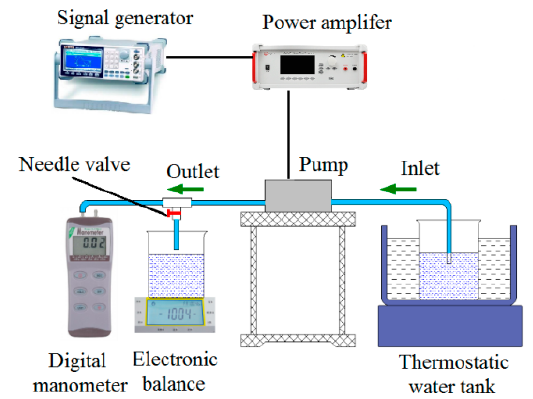
Figure 14. Schematic illustration of the experimental device.